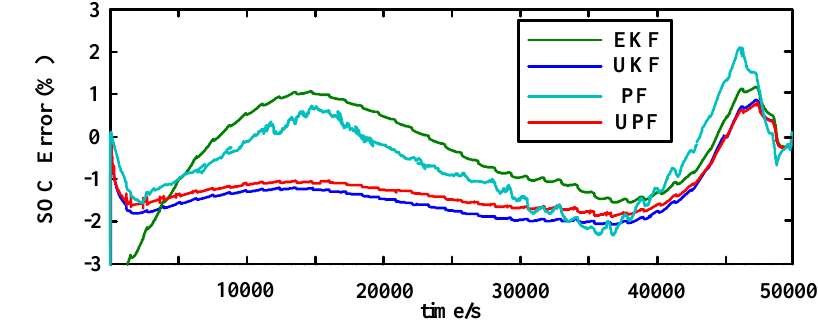
unscented Kalman filter; PF, particle filter, UPF, unscented Kalman particle filter.